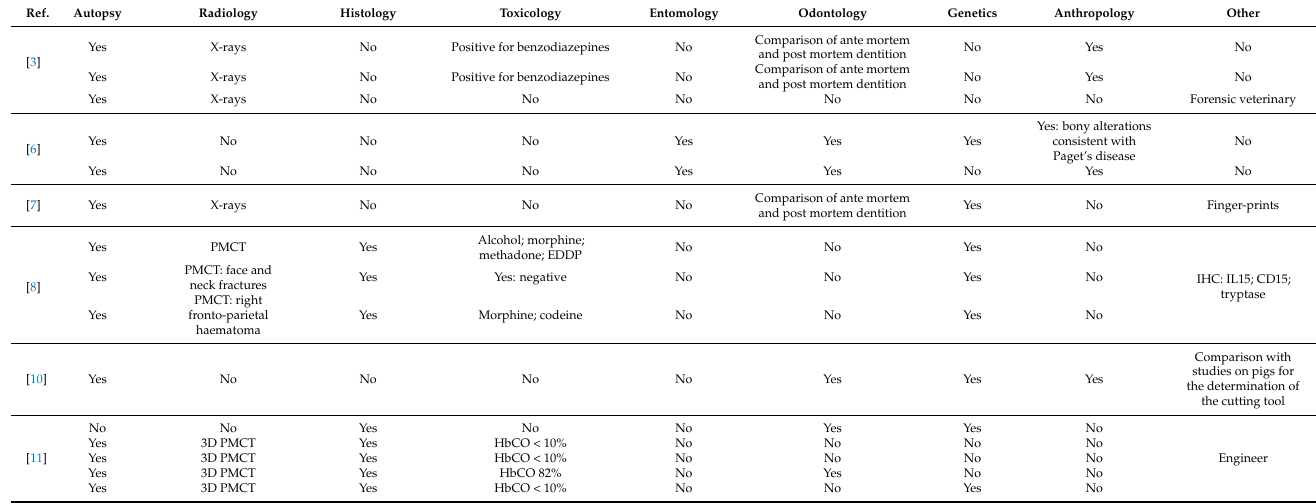
Comparisonwith studiesonpigsfor thedeterminationof